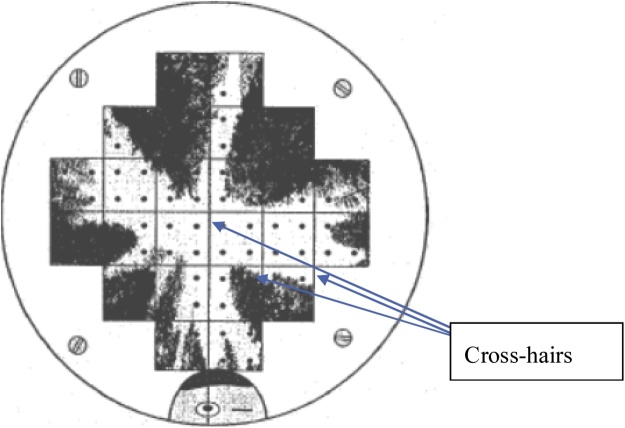
View of densiometer mirror.Placement of observer’s head and the 37 cross-hairs are shown. In this example there are 12 out of 37 cross-hairs that are open. Note: ignore the dots in the diagram as they are not relevant for the way that we are recording cover data.Diagram Diagram taken from Shuett-Hames et al.